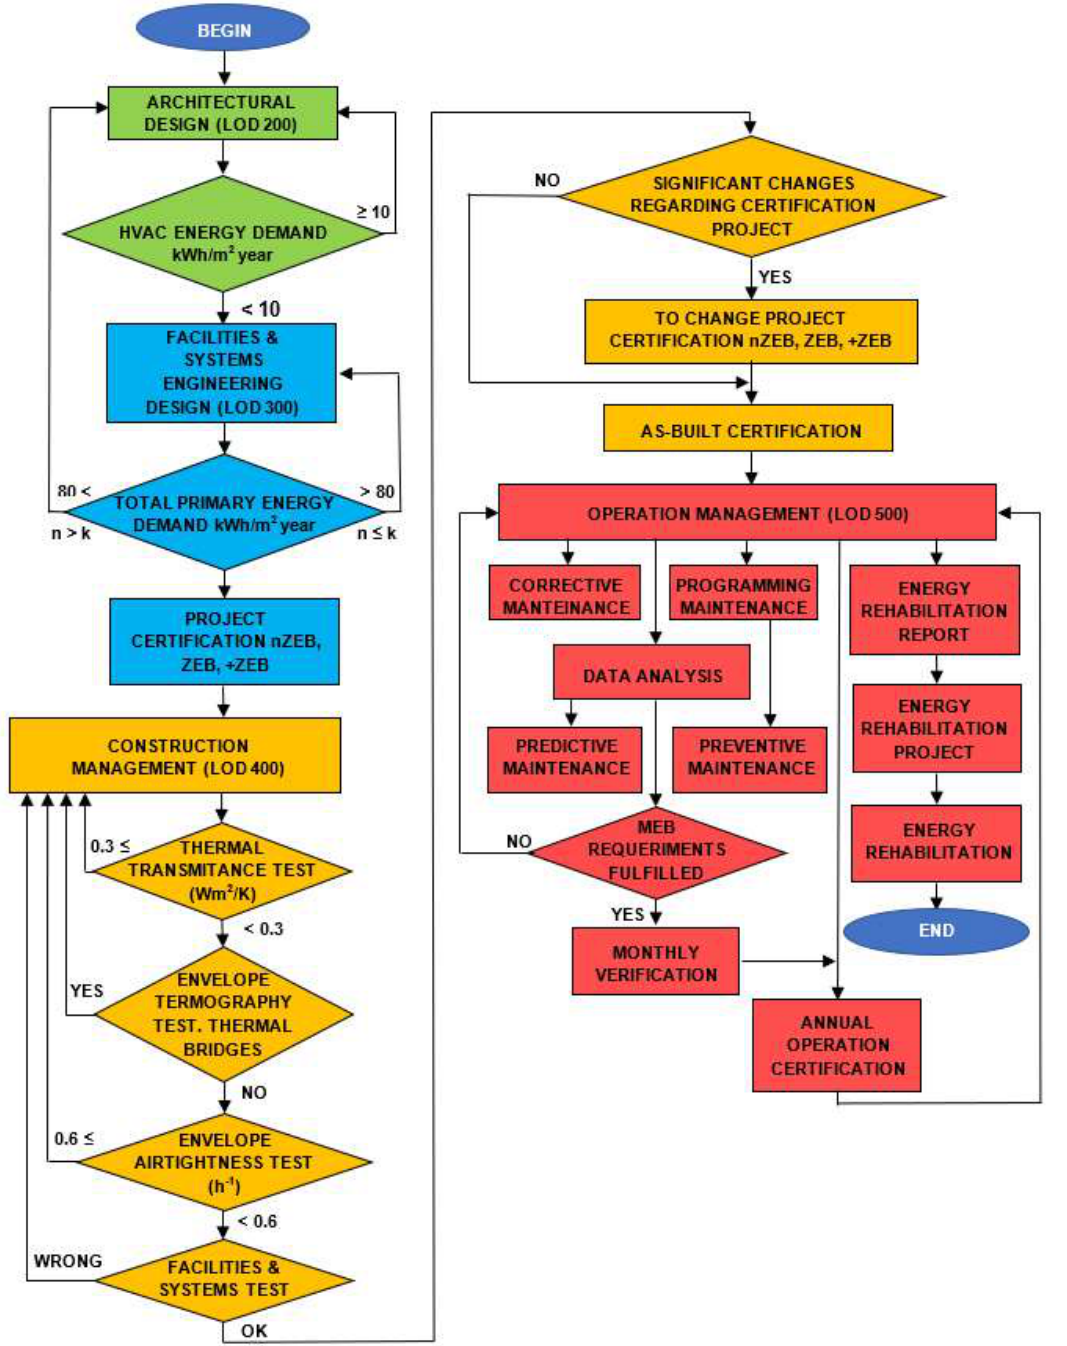
Figure 7. The uhuMEB algorithm in subtropical climates: MEB implementation.